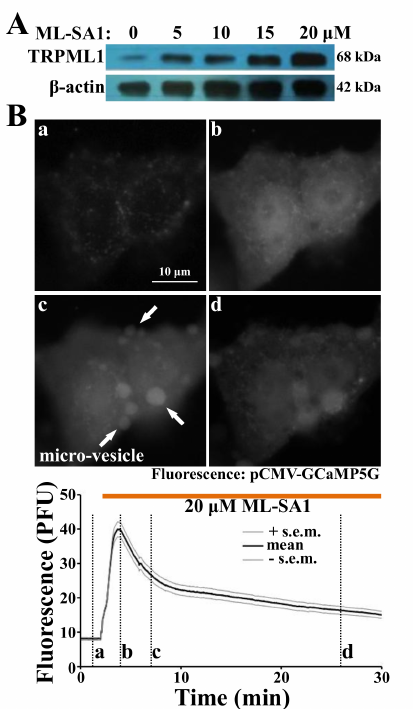
Figure 5. ML-SA1 activated TRPML1 in AGS cells. (A) Western blot of the TRPML1 expression in AGS cells after the application of various concentrations of ML-SA1. (B) The cytosolic calcium concentration change in calcium sensor transfected AGS cells after the treatment of 20 μM ML-SA1. White arrow, micro-vesicles formed after the application of ML-SA1. Scale bar, 10 μm.